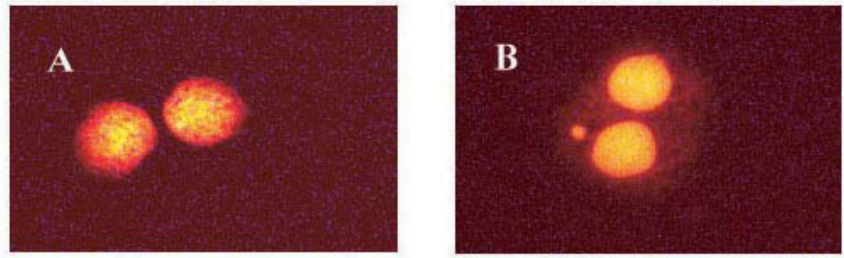
FIGURE 6 . (A) Binucleated cell without MN; (B) Binucleated cell with